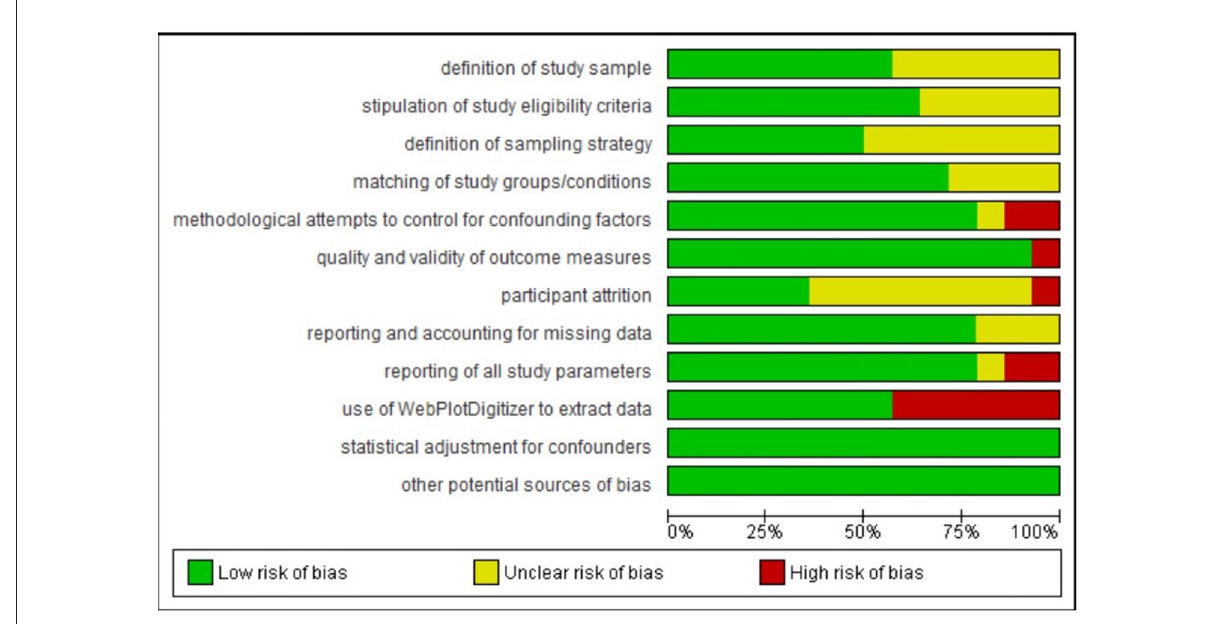
FIGURE3 Percentage of studies in the metanalysis rated as being of low, unclear, and high risk of bias on each rated methodological dimension ( N =